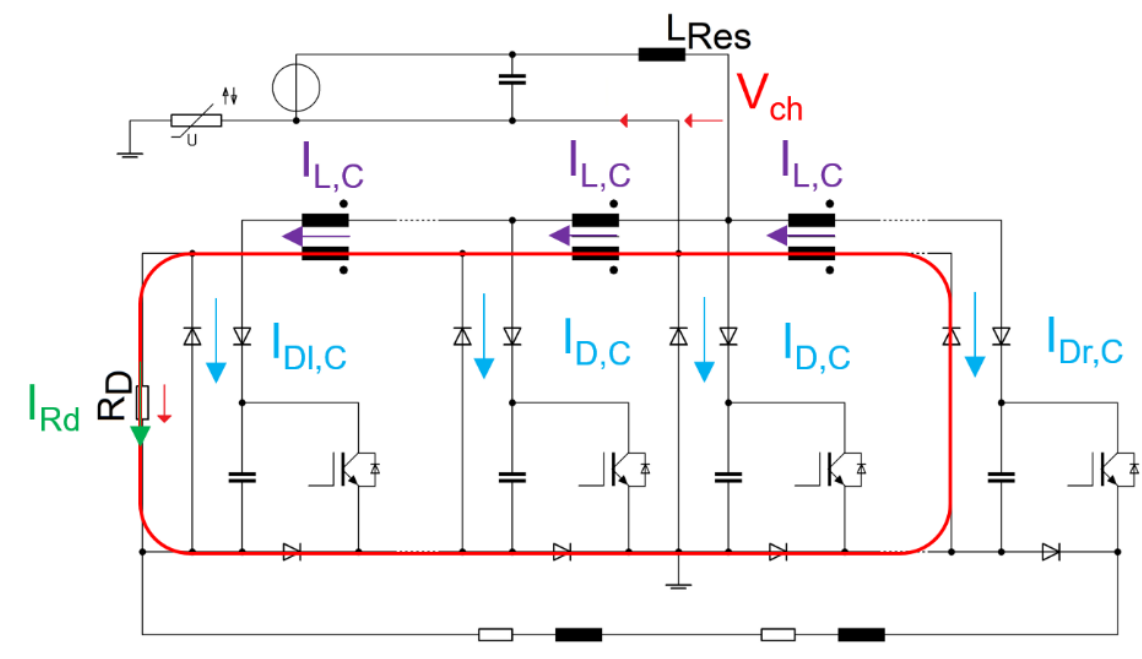
Figure 23. Equivalent circuit showing current paths.